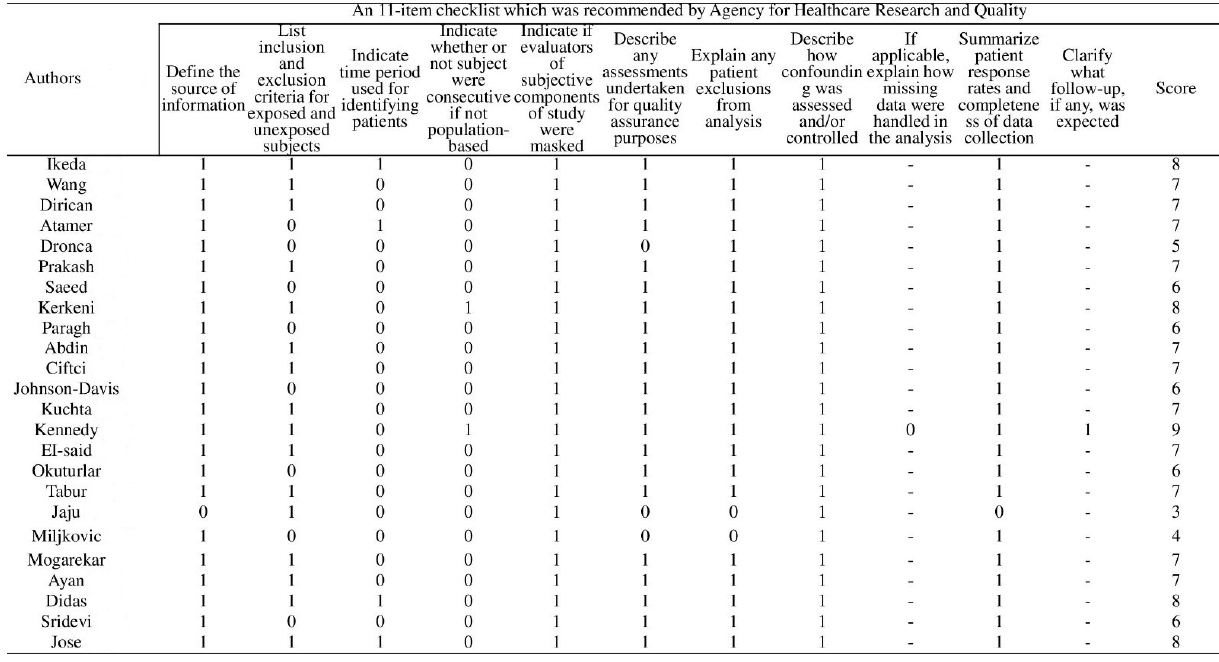
Figure A1. Details of risk of bias assessment [26–49].